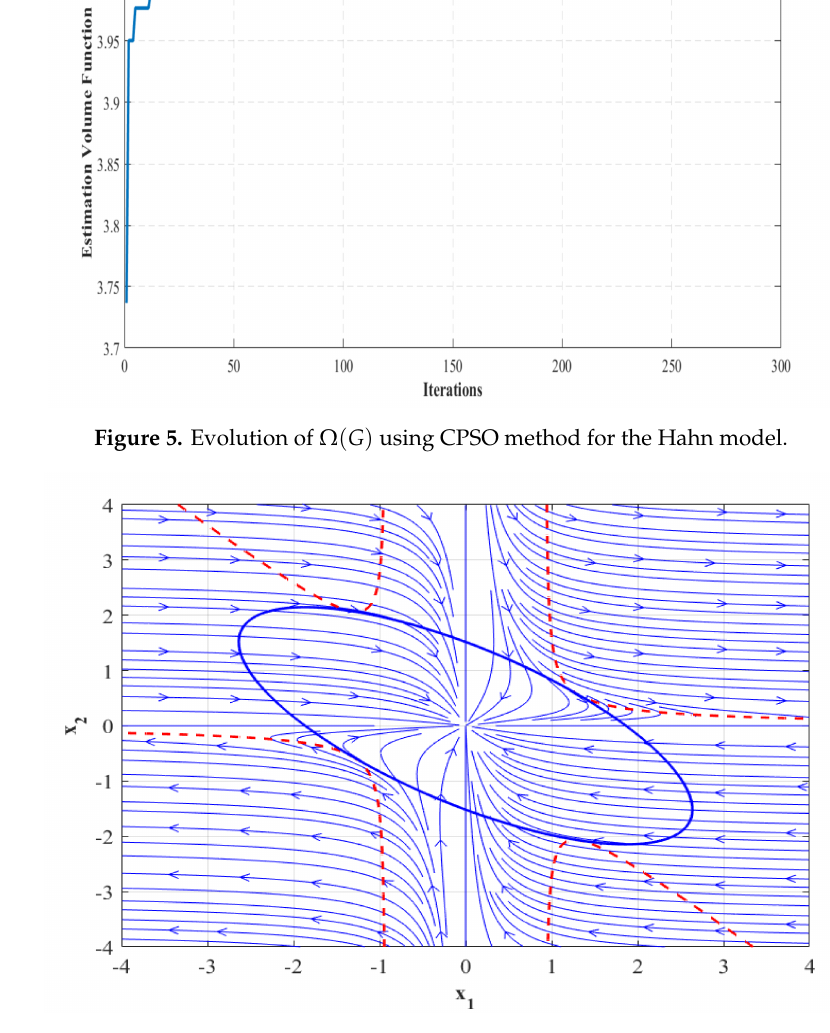
Figure 6. Approximated DA for the Hahn model with CPSO method. Blue ellipsoid represents the DA estimate, red dashed line (the boundary of the DA estimate) represents the region in which